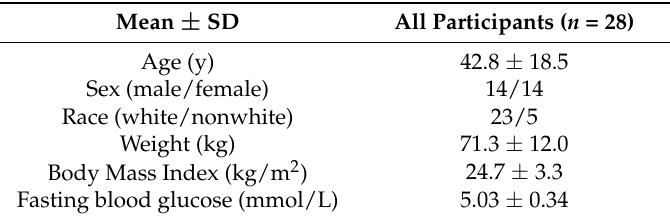
Table 2. Subject demographics.